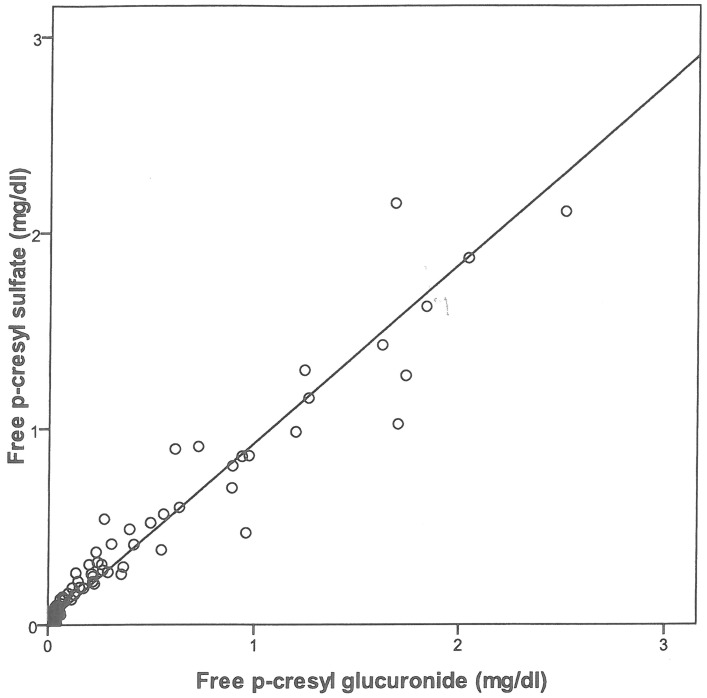
Linear regression curves showing the relationship between free p-cresylglucuronide serum levels and free p-cresylsulfate serum levels; r2 = 0.95, p<0.0001.